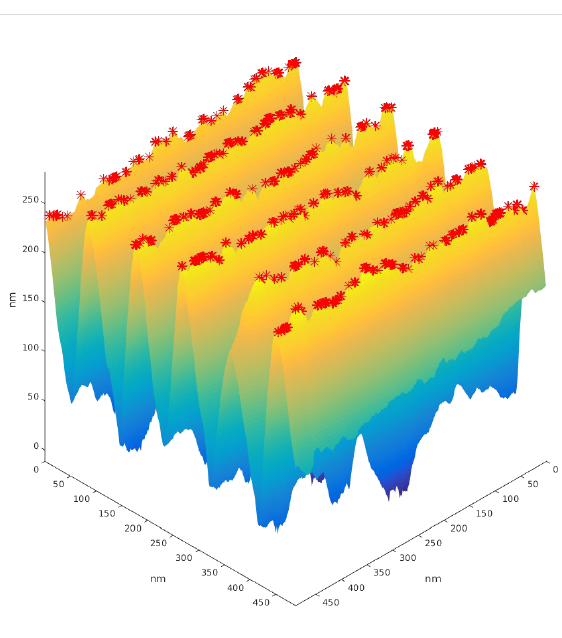
Figure 4: Plot of an actual saw-tooth copy showing the average height maxima (red points). HOG parameter: The histogram of oriented gradients (HOG) is a feature descriptor widely used in image processing. First